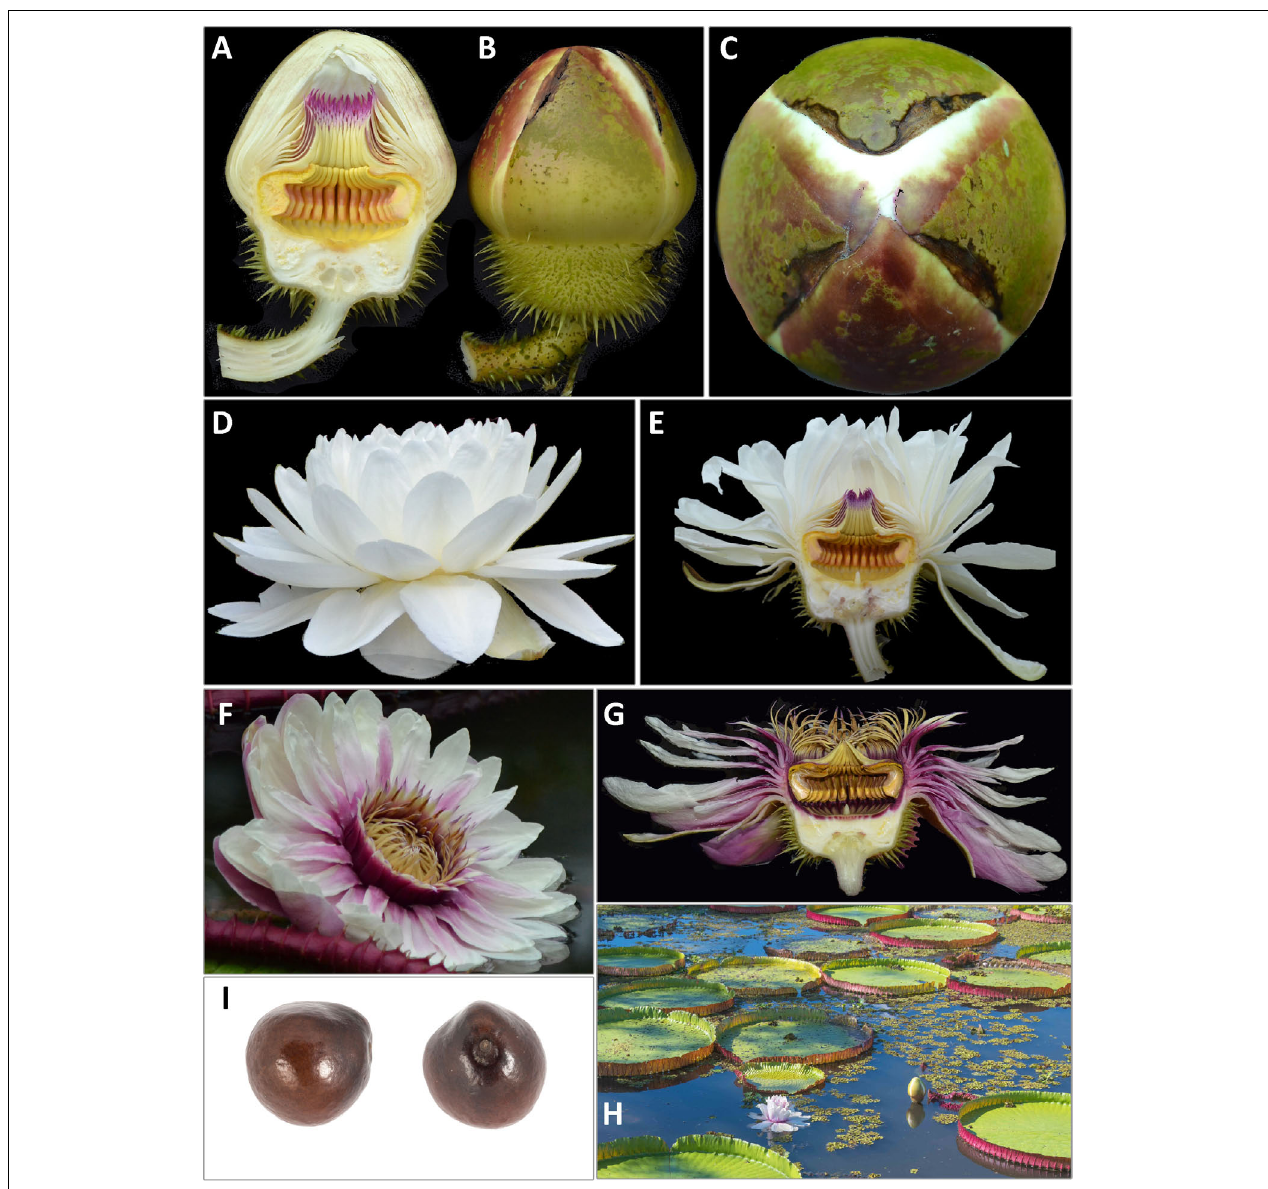
FIGURE 10 | Victoria boliviana sp. nov. (A) bud whole, (B) bud L. S., (C) bud from above, (D) first night flower, (E) first night flower L. S., (F) second night flower, (G) second night flower L.S., (H) habit, and (I) seed. (A–G) (LTS), (I) (CM) cultivated RBG Kew, H (CM) Beni, Bolivia.